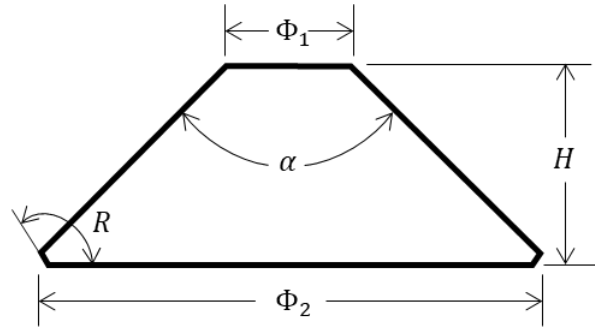
Figure 1. Structural parameters of sample. Table 1. Mechanical parameters of the PMMA sample. Table 1. Mechanical parameters of the PMMA